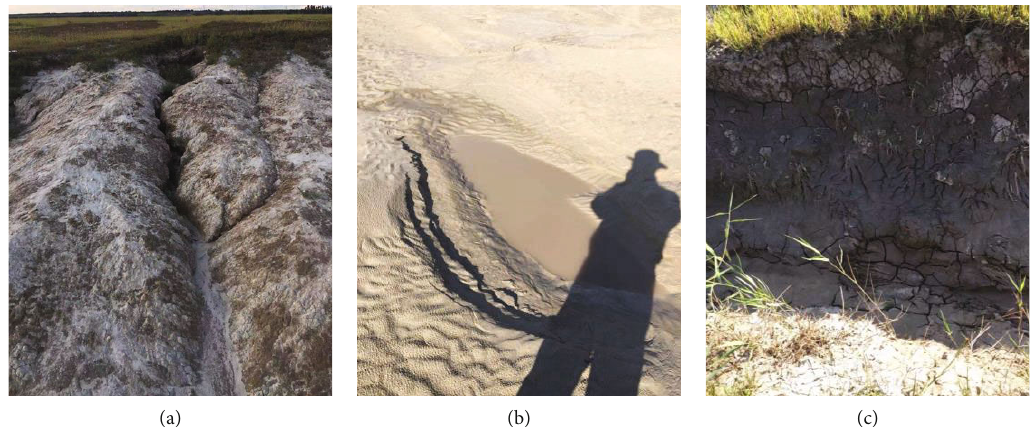
Figure 2: Dispersion characteristics of the soil in the study area: (a) dissolution phenomenon; (b) water turbidity; (c) cracking